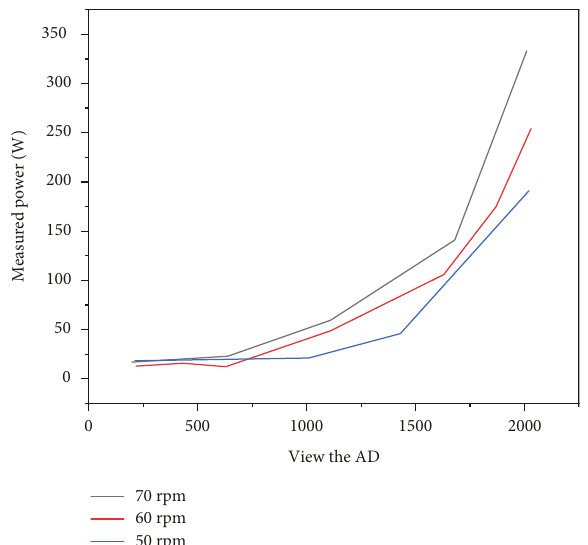
Figure 7: The relationship between power and angle.